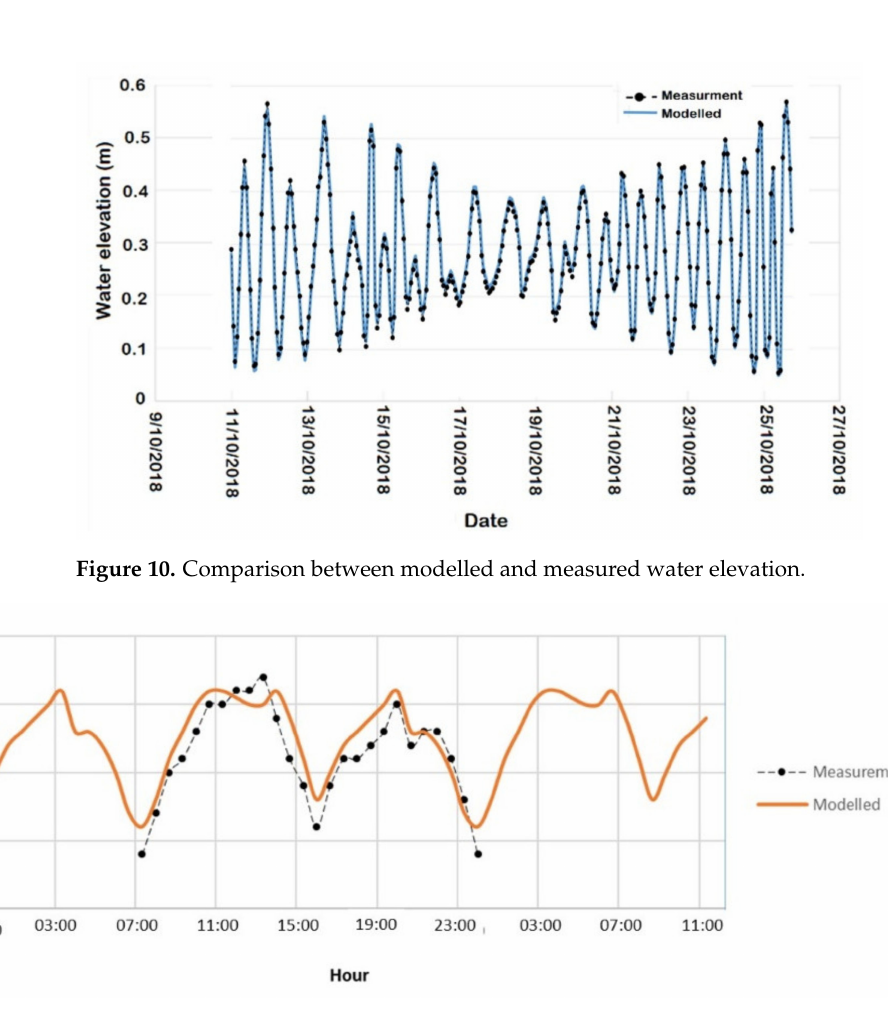
Figure 11. Comparison of depth-averaged velocity between the modelled (solid line) and the observed (dot line) data. The final input parameters used for the Delft3D model simulation are shown in Tables 3 and 4 below. In this model, modeling was conducted for a 1-month simulation period. Table 3. Hydrodynamic parameters.